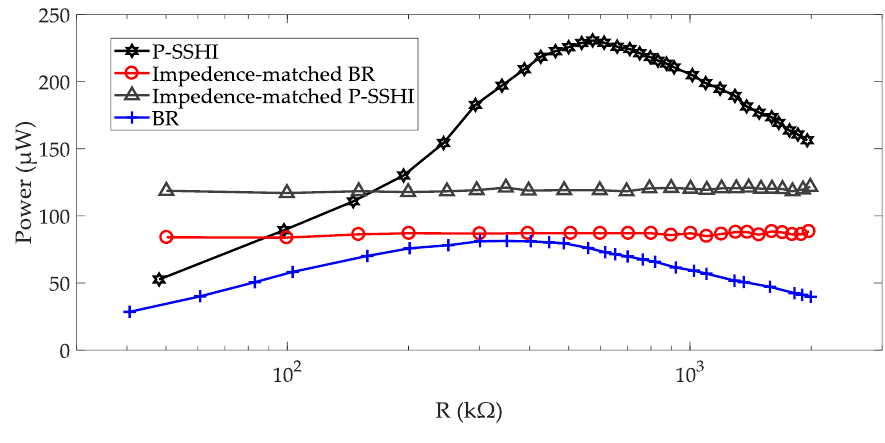
Figure 12. Harvested power versus load.